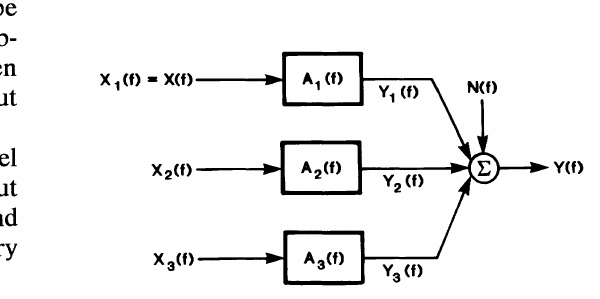
FIGURE 9 Three-input/single-output linear